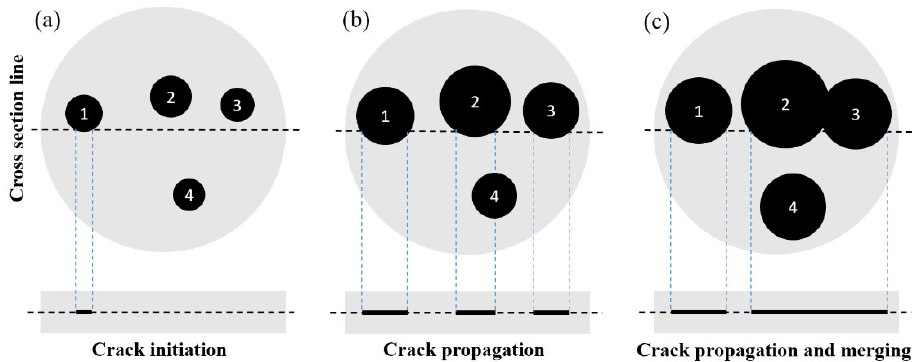
Figure 9. Schematic diagram of crack evolution behavior in the coating during thermal cycling: ( a ) crack initiation; ( b ) crack propagation and ( c ) crack coalescence.